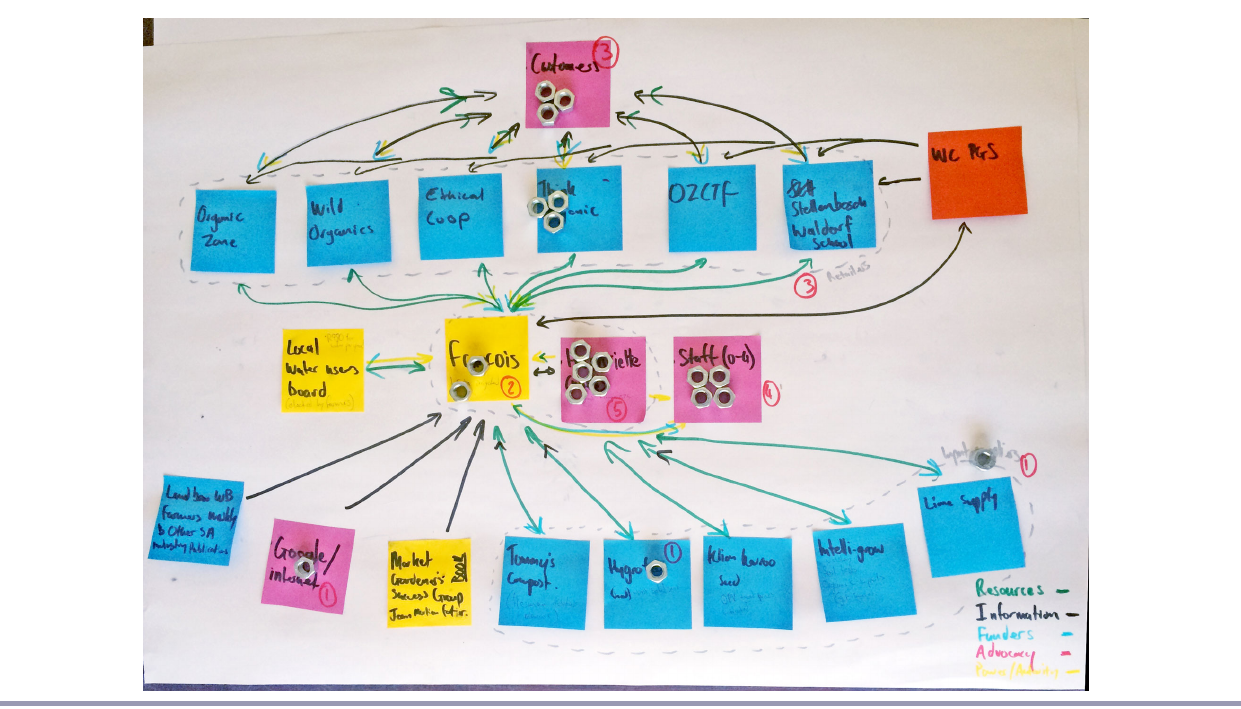
Fig. 1 . Example of completed farmer